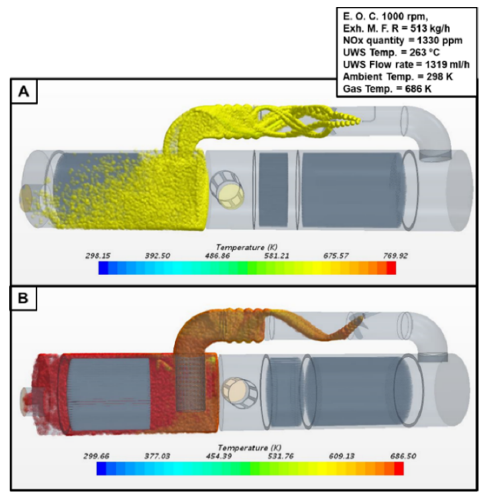
Figure 2. Temperature phenomena in the SCR: ( A ) L-type urea injector and ( B ) I-type urea injector.